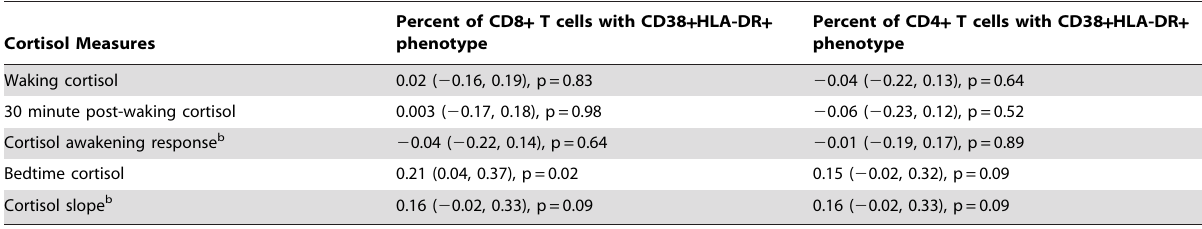
Table 3. Correlations of T cell percent antigen expression with cortisol measures a .